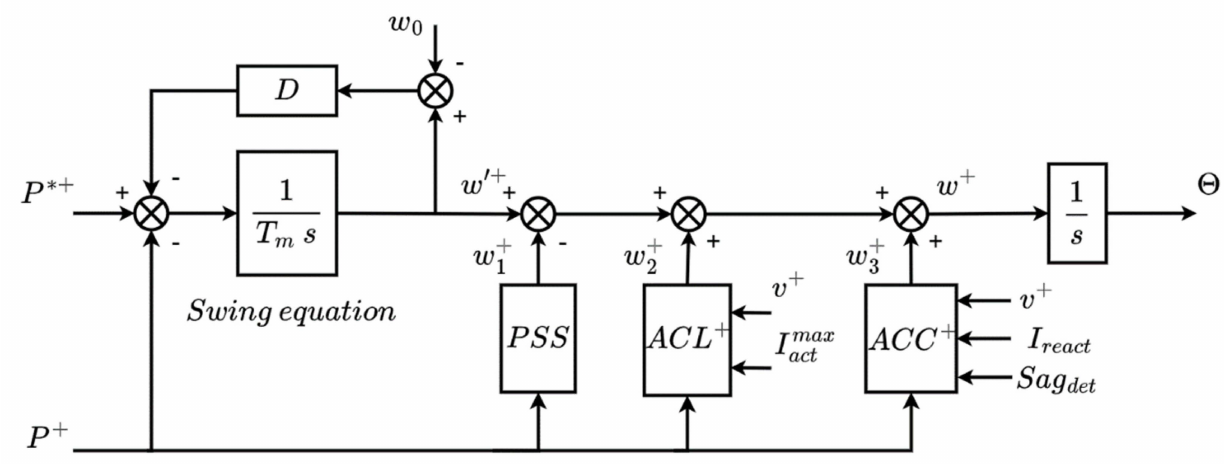
Figure 5. Positive active power controller block.